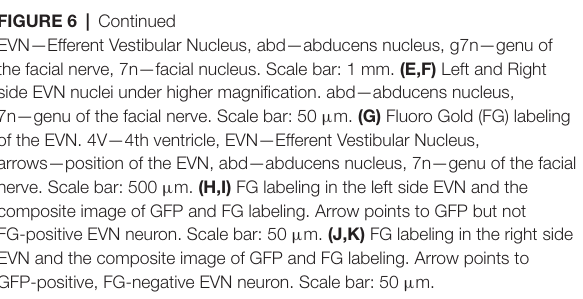
FIGURE 6 | Continued EVN—Efferent Vestibular Nucleus, abd—abducens nucleus, g7n—genu of the facial nerve, 7n—facial nucleus. Scale bar: 1 mm. (E,F) Left and Right side EVN nuclei under higher magnification. abd—abducens nucleus, 7n—genu of the facial nerve. Scale bar: 50 µ m. (G) Fluoro Gold (FG) labeling of the EVN. 4V—4th ventricle, EVN—Efferent Vestibular Nucleus, arrows—position of the EVN, abd—abducens nucleus, 7n—genu of the facial nerve. Scale bar: 500 µ m. (H,I) FG labeling in the left side EVN and the composite image of GFP and FG labeling. Arrow points to GFP but not FG-positive EVN neuron. Scale bar: 50 µ m. (J,K) FG labeling in the right side EVN and the composite image of GFP and FG labeling. Arrow points to GFP-positive, FG-negative EVN neuron. Scale bar: 50 µ